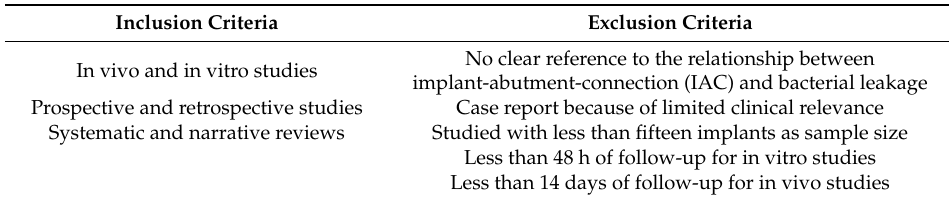
Table 1. Inclusion and exclusion criteria.